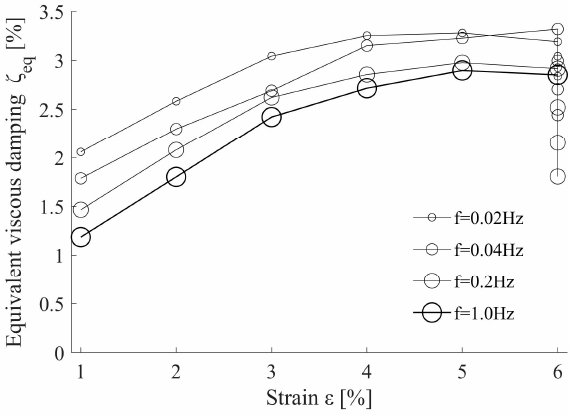
Figure 11. Equivalent damping ζ eq for 12.7 mm diameter NiTi bars.